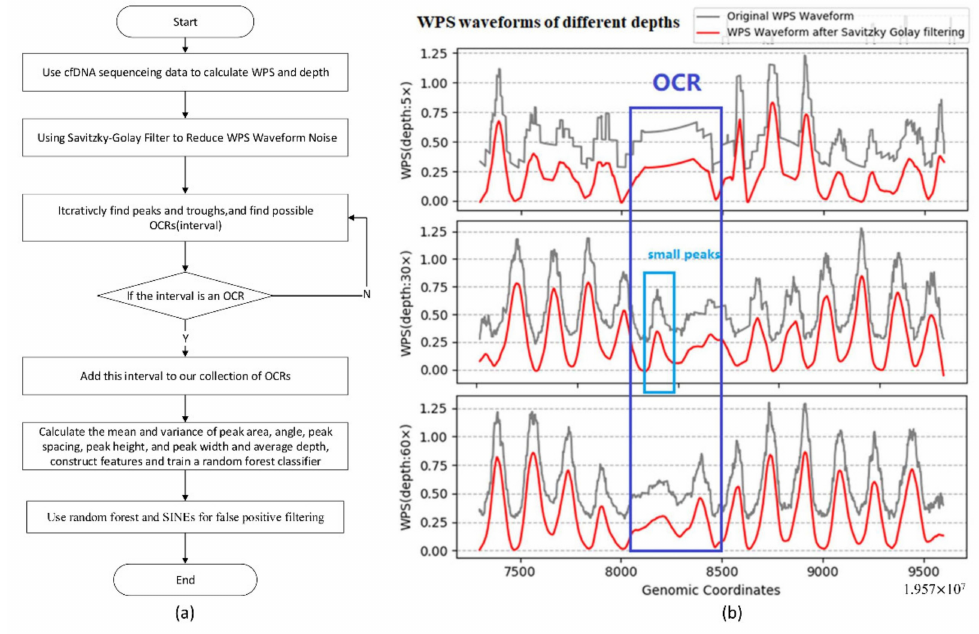
Figure 7. ( a ) The pipeline of our method. ( b ) The WPS waveforms at different coverages (60 × , 30 × , 5 ×